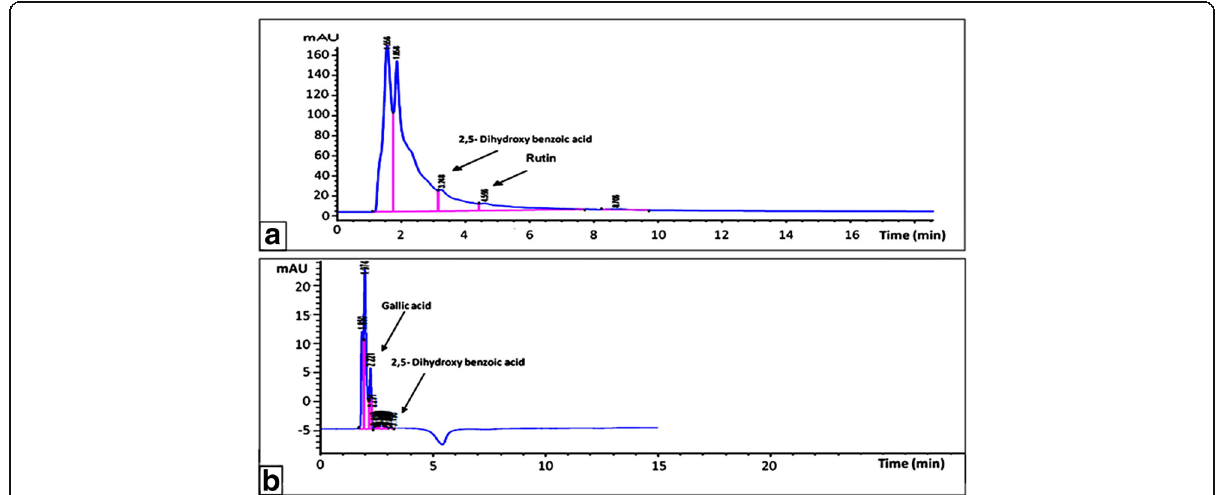
Fig. 1 HPLC chromatograms of the phenolic compounds in (a) GLE, and (b)